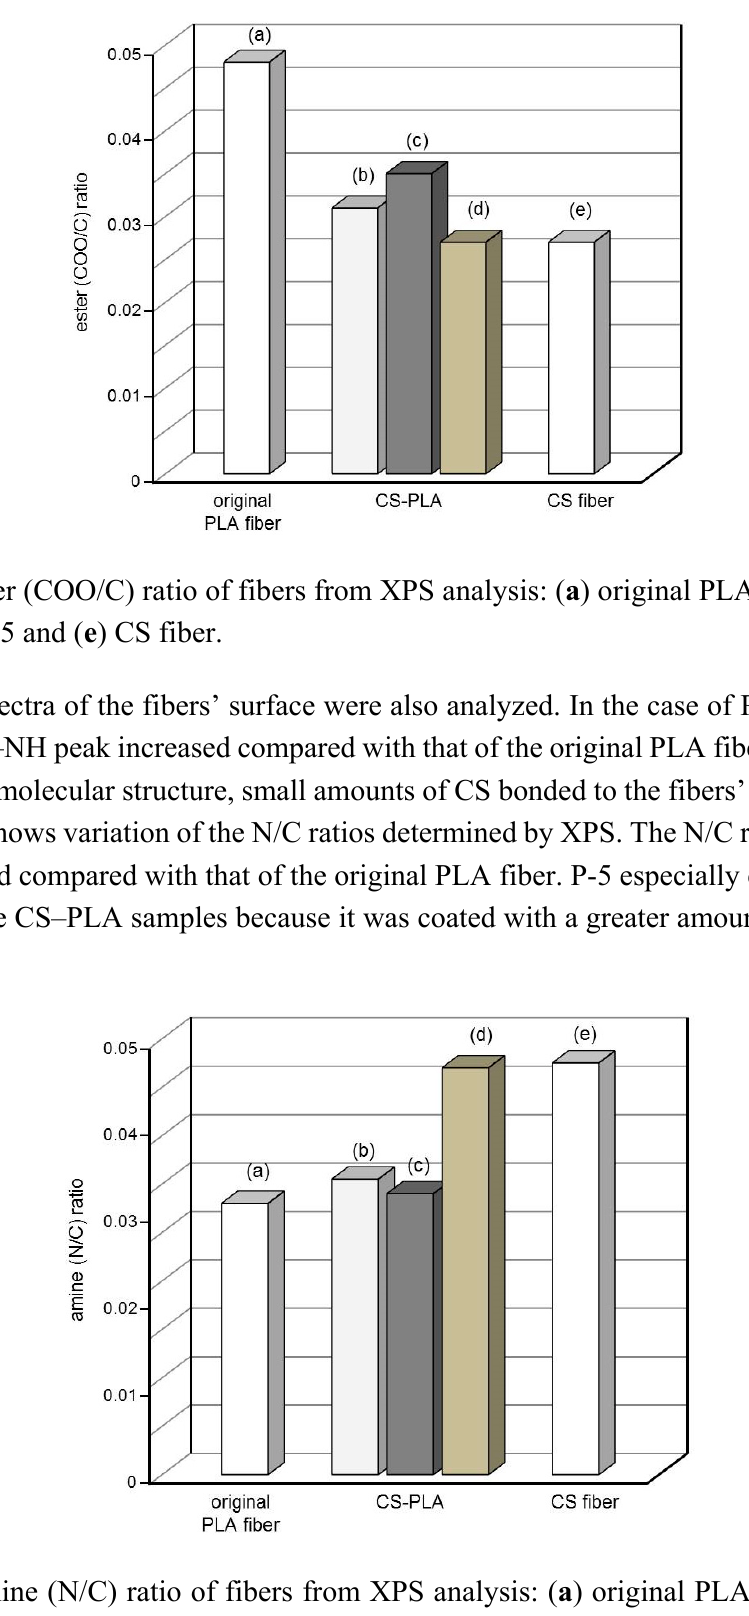
Figure 6. Amine (N/C) ratio of fibers from XPS analysis: ( a ) original PLA fiber; ( b ) P-3; ( c ) P-4; ( d ) P-5, and ( e ) CS